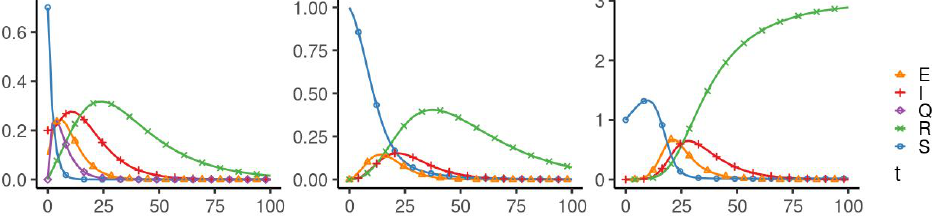
Figure 21. Experiment 4. Spread of the virus in the uncontrolled case (irresponsible individuals). ( Left ): 1 level, ( middle ): 2 level, ( right ): 3